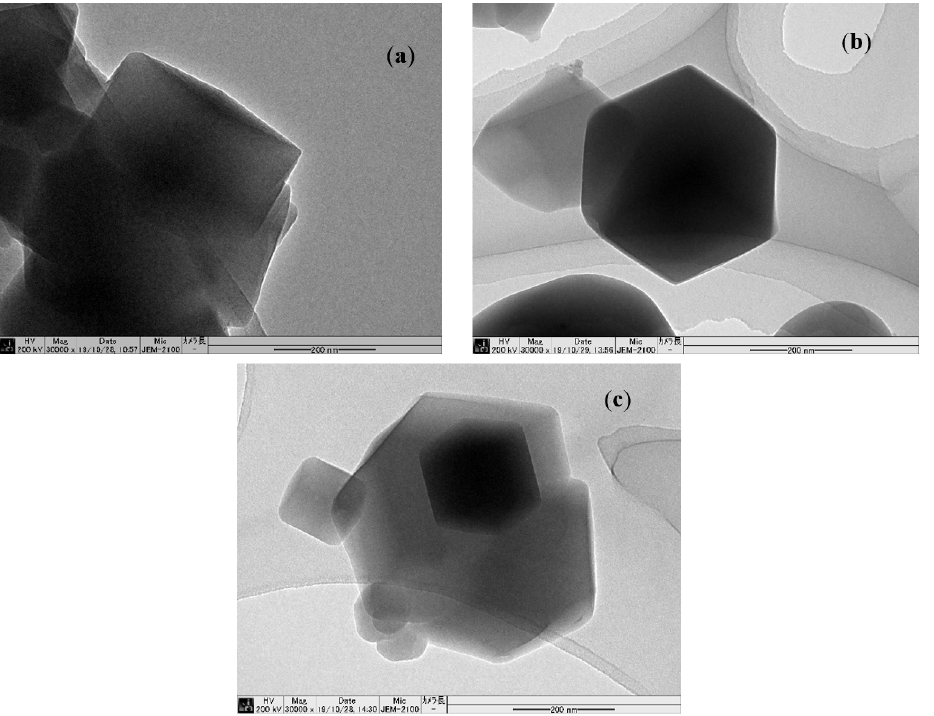
Figure A5. TEM imaging (30k × magnification) of ( a ) ZIF-8; ( b ) [EMIM][TCM]@ZIF-8(high); and ( c )